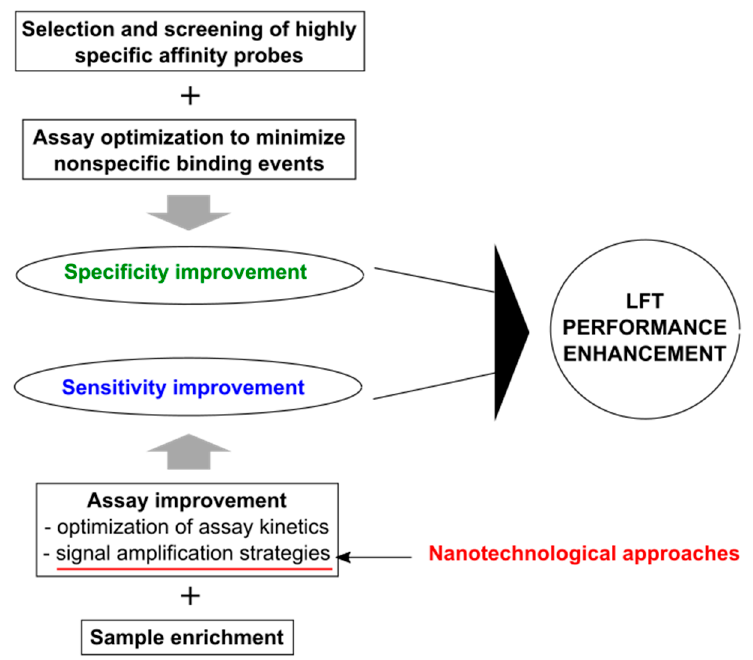
Figure 2. Schematic of the main points under the enhancement of LFT detection performance. The main contribution of nanotechnological approaches is highlighted in red.